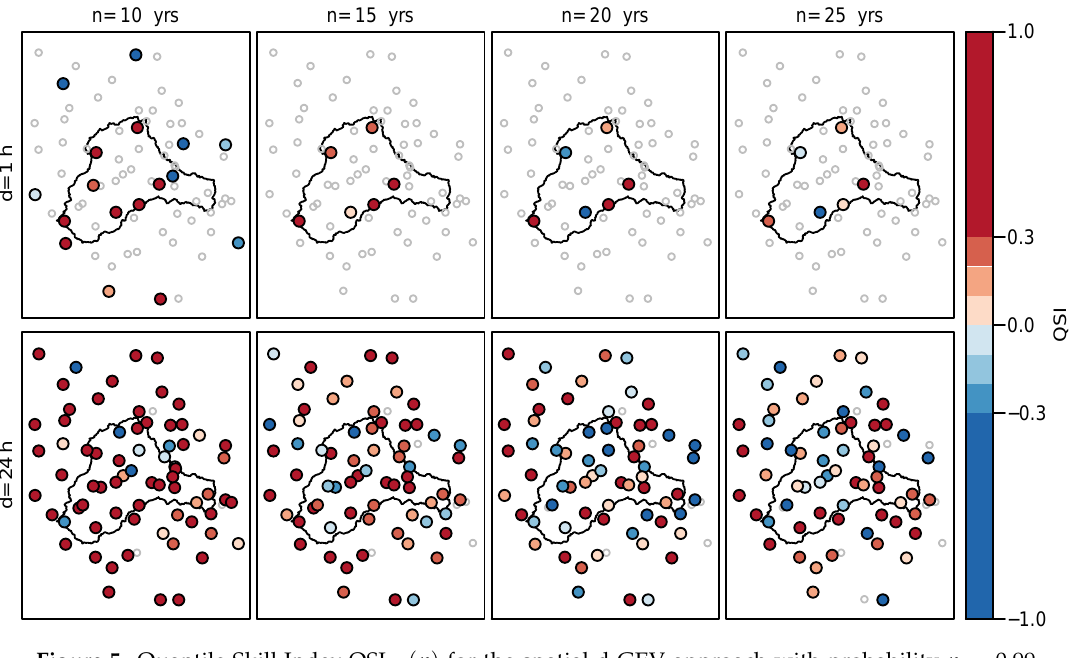
Figure 5. Quantile Skill Index QSI s , d ( p ) for the spatial d-GEV approach with probability p = 0.99 for durations d = 1h (upper panel) and d = 24h (lower panel) at all stations, for the number of training years n train = { 10,15,20,25 } (different columns). Colored dots indicate superiority of the spatial d-GEV (red) or inferiority (blue), while gray circles show stations without an